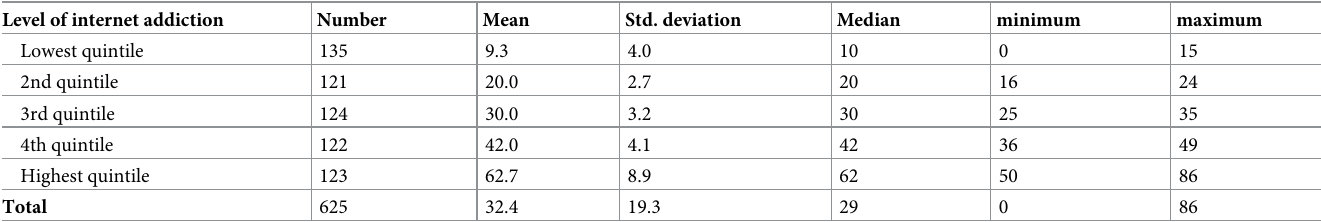
Table 2. Breakdown of internet addiction scores by the five levels of internet addiction.